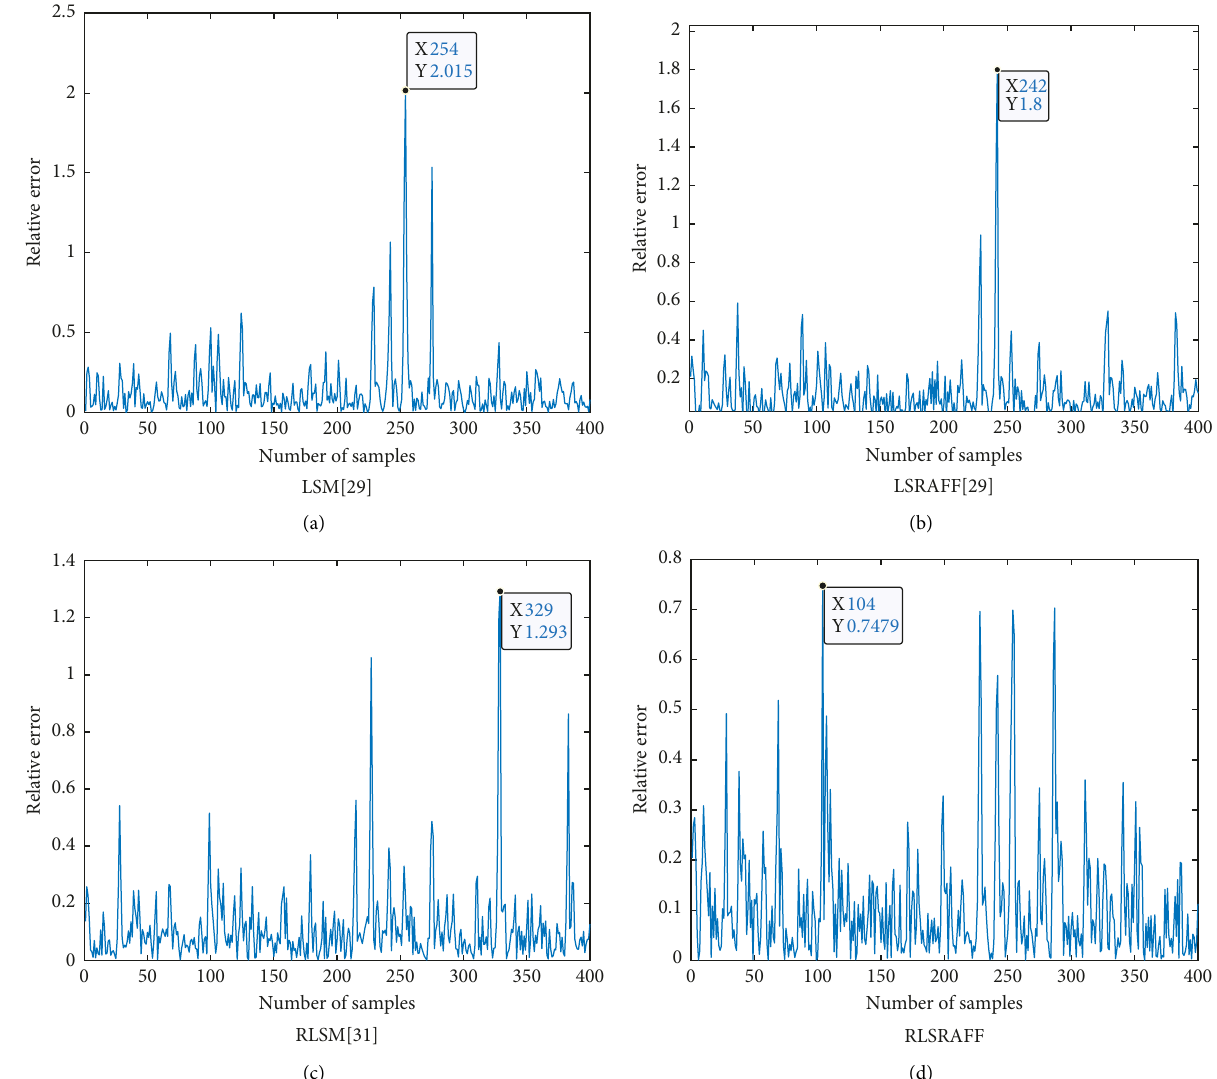
Figure 4: The relative error between the estimated value and the true value of system